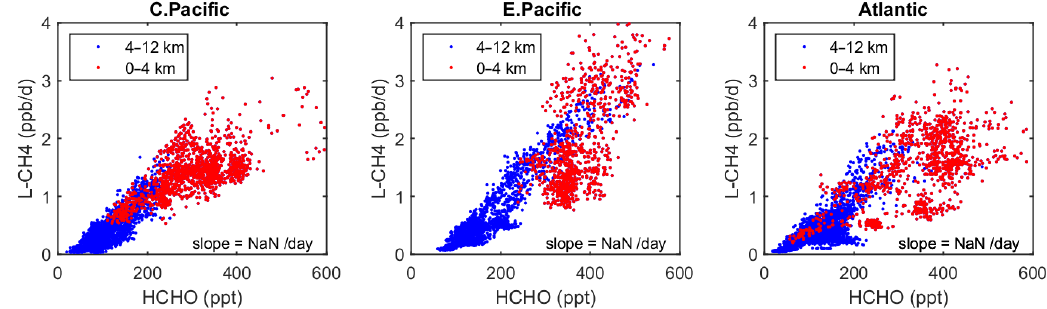
Figure 6. Scatterplot of L-CH4 (ppb/d) versus HCHO (ppt) for ATom 1 in the three tropical regions shown in Fig. 3. The air parcels are split into the lower troposphere (0–4km pressure altitude, red dots), where most of the reactivity lies, and the middle and upper troposphere (4–12km, blue). A simple linear fit to all data is shown (thin black line), and the slope is given in units of 1 per day.